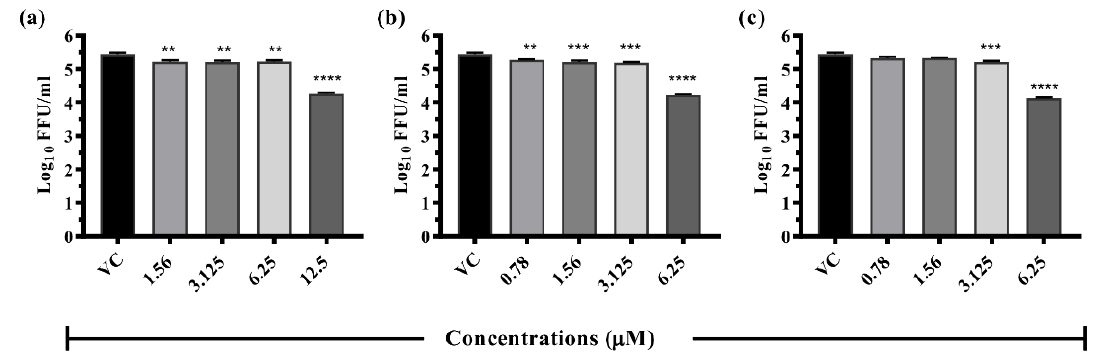
Figure 4. Antiviral effects of resveratrol, lomibuvir, and elvitegravir against DENV under pre-treat-